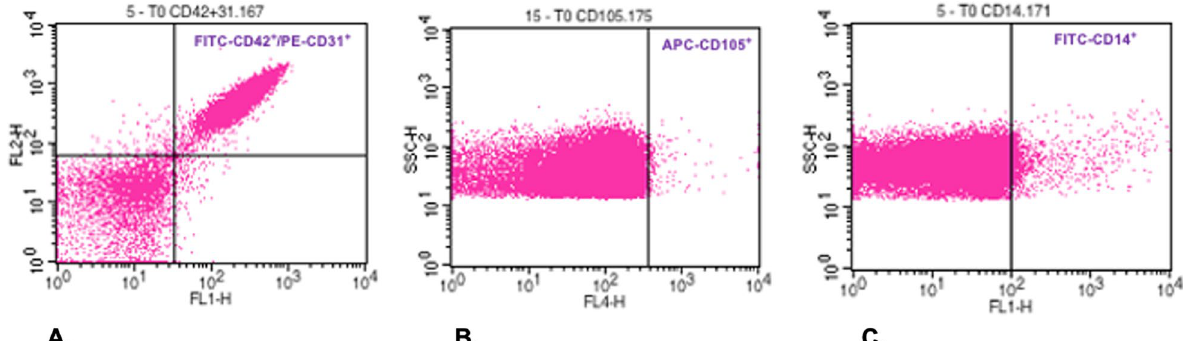
Fig. 1 Flow cytometry plots gated events of microparticles from a representative patient with systemic sclerosis. A . Platelet-derived microparticles. B Endothelial cell-derived microparticles. C Monocyte-derived